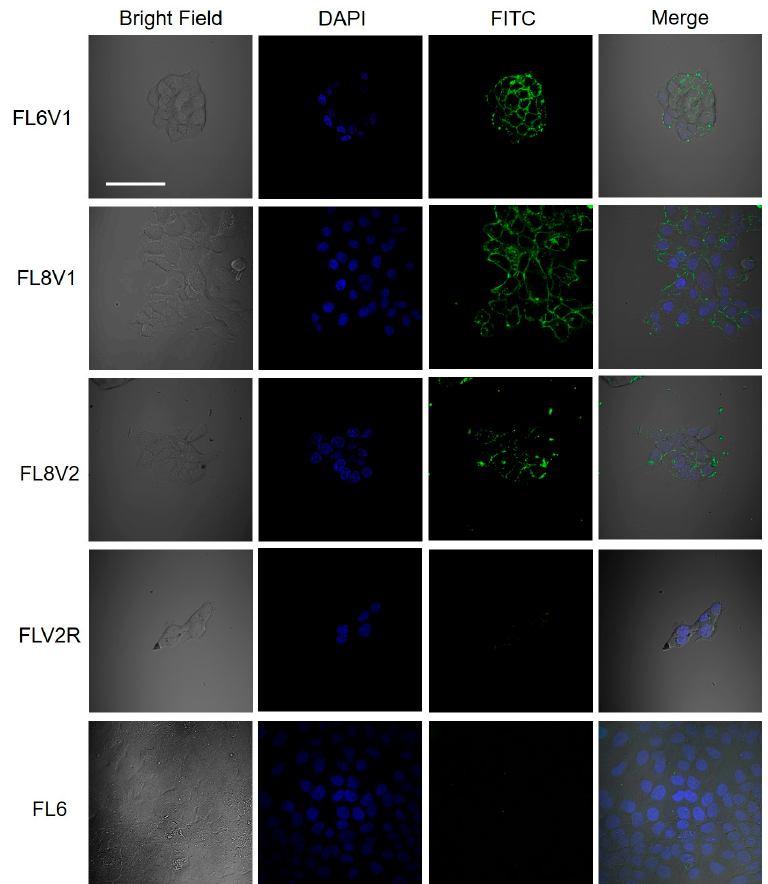
Figure 1. Confocal microscopy images of FaDu cells incubated for 30 min with hybrid peptides (50 µM) at 37 °C; bar represents 50 µm.